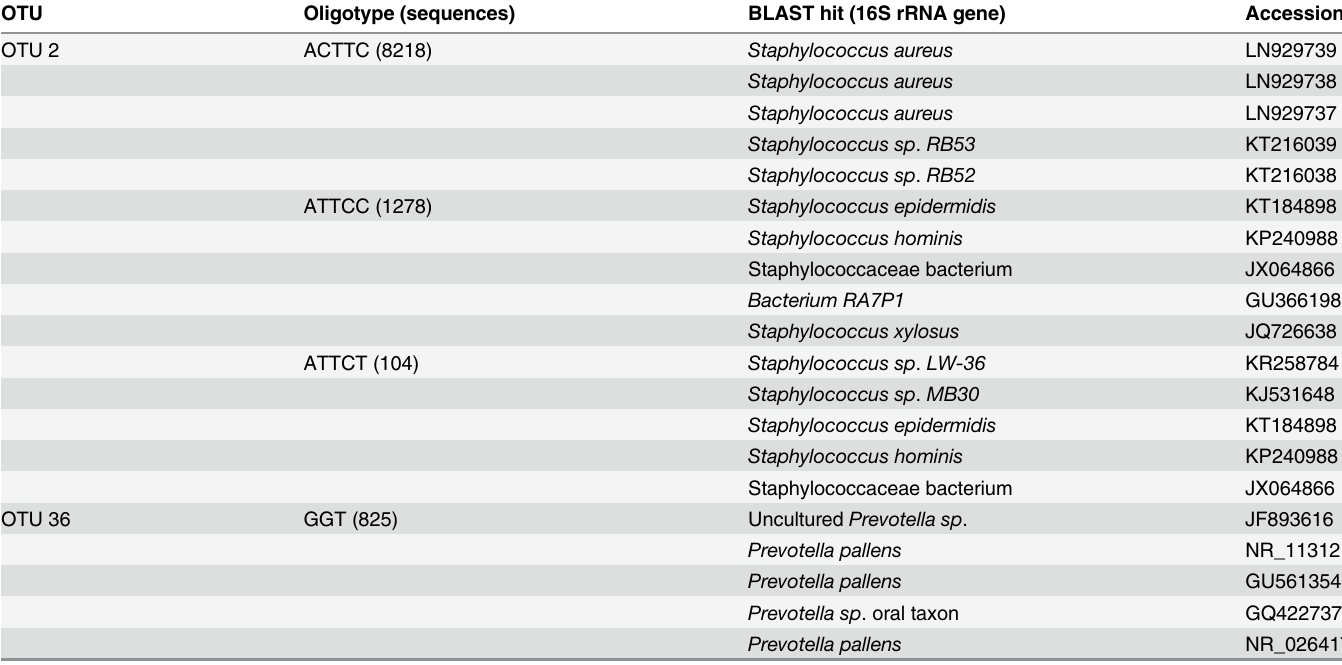
Table 2. BLAST analysis of OTU 2 and OTU 36